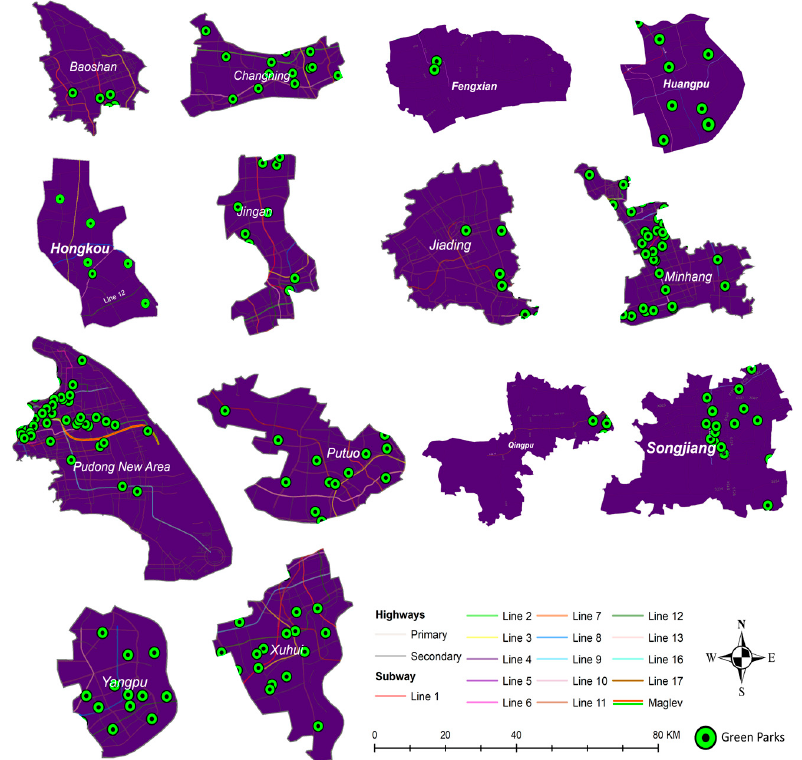
Figure 5. Parks’ distribution at the district level in Shanghai.